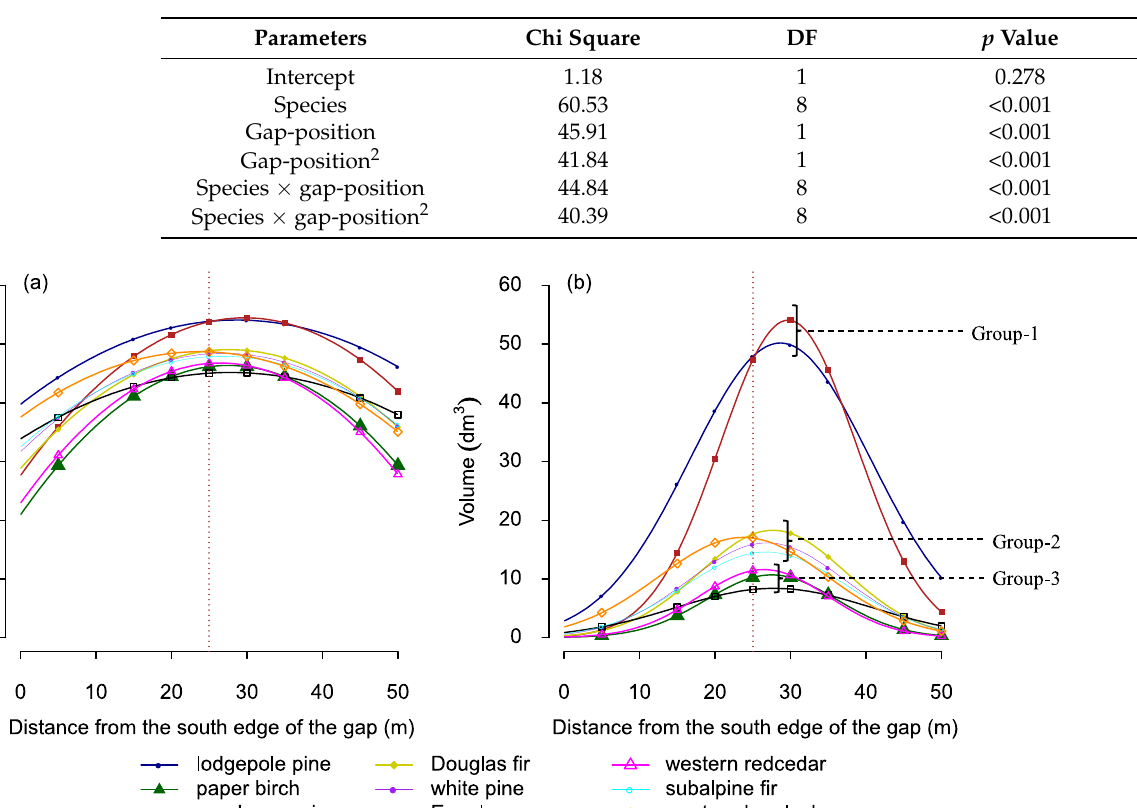
Table 3. Analysis of Deviance table (Type III Wald chisquare tests) of the mixed effect regression model (Equation (3)) describing species’ growth (log-volume) response to changing gap environments (gap-position).